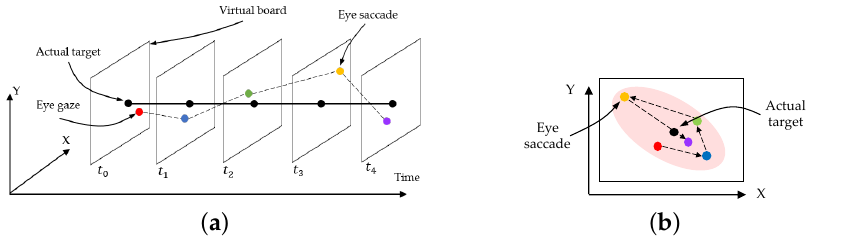
Figure 30. Error caused by saccade: ( a ) Eye gazes in time domain, and ( b ) Eye gazes in Hough